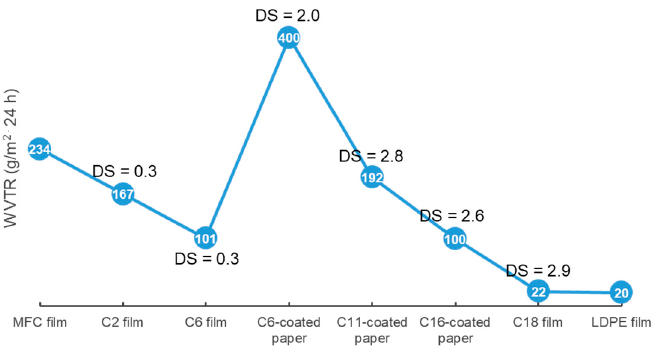
Figure 4. WVTR of CMF film, cellulose ester packaging and LPDE film [5,96,102,105,109].